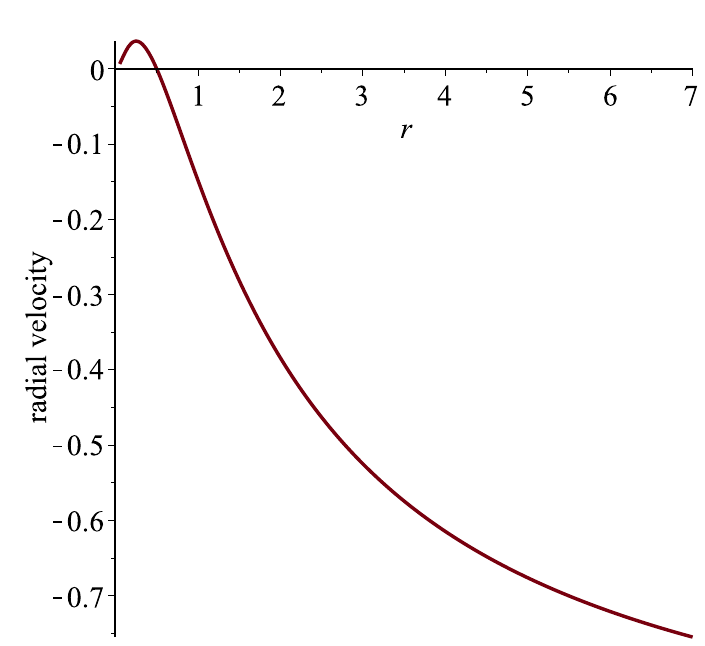
√ 5 ≈ 0.263932023. 2